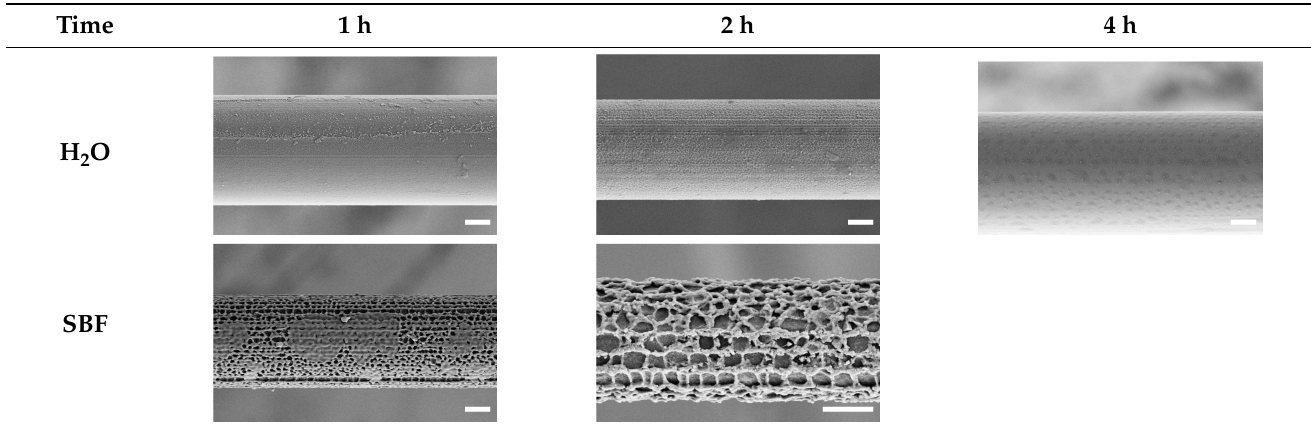
Table 9. SEM images of the dissolution of the fibres of the glass 1-06 (scale: